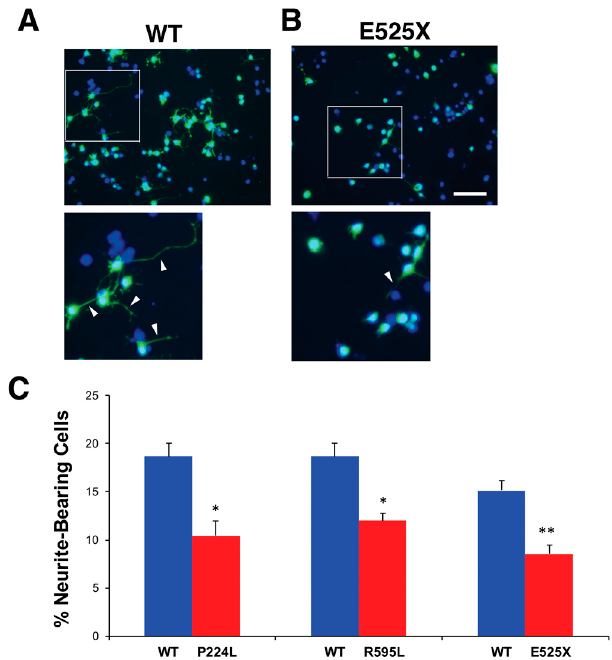
Figure 6. N2A cells transfected with VGF SNP plasmids exhibit fewer neurites. ( A , B ) Representative images of N2A cells expressing plasmid containing either WT VGF ( A ) or E525X mutation in VGF ( B ) and stained for GFP ( green ) and DAPI ( blue ). Higher magnification view of boxed area is shown below. Neurites are visible extensions from the cell body as indicated by white arrowheads. Scale bar = 100 µ m in top images and 60 µ m in bottom; and ( C ) quantification of neurite extension from N2A cells. Bars represent average percent neurite-bearing cells ± SEM. 150 cells/dish were counted ( n = 3), Two-sample t test: WT vs. P224L t(4) = − 2.24, p = 0.015. WT vs. R595L t(4) = − 2.21, p = 0.014. WT vs. E525X t(8) = − 3.40, p = 0.002. * p < 0.05, ** p < 0.01, unpaired t -test.